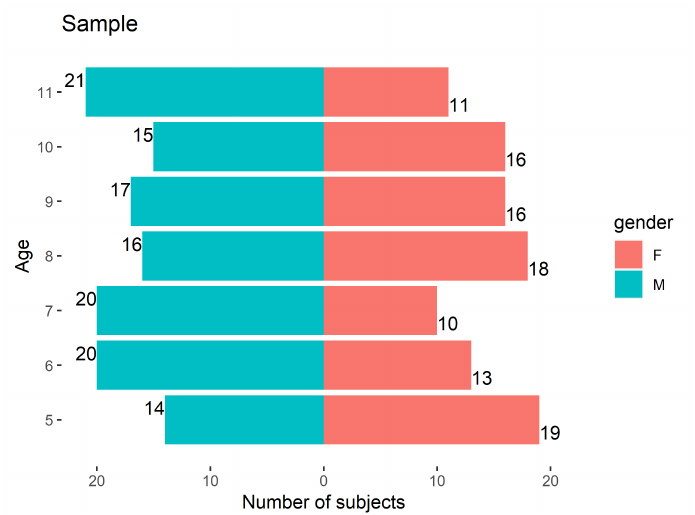
(94.0%) right-handed, 12 (5.5%) left-handed, 1 (0.5%) ambidextrous.